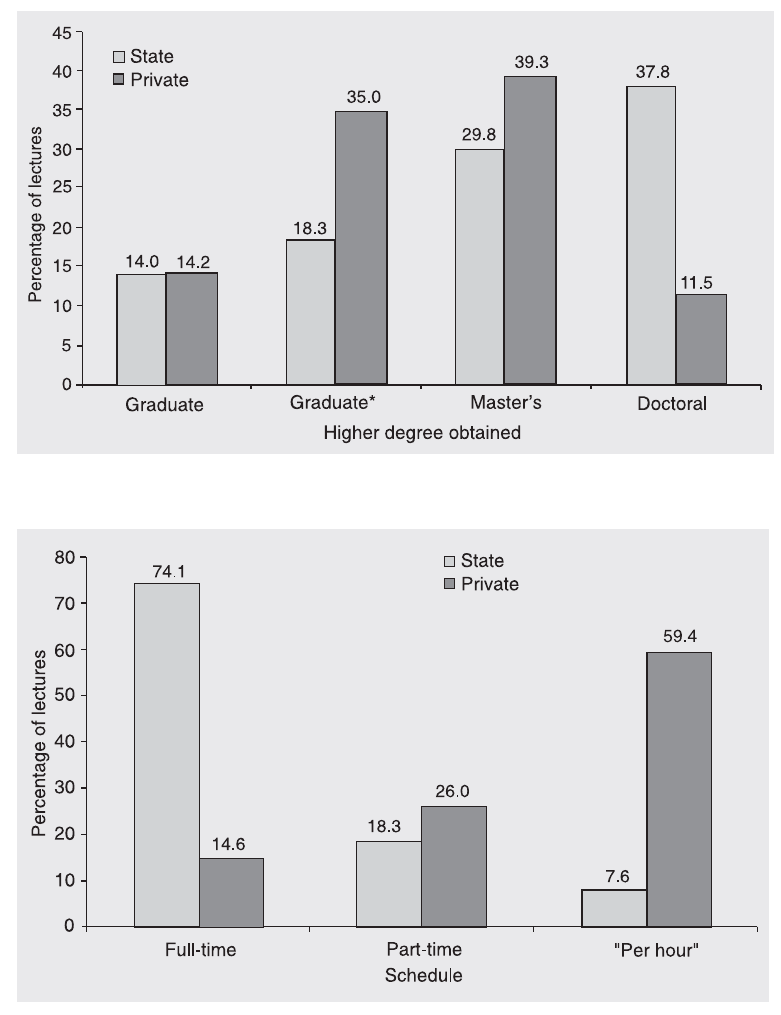
Figure 12. Percentage of lecturers employed by state and private universities as a function of higher degree obtained, calculated based on data available in June 2003 (original data source: INEP, http://www.inep. gov.br/). *Graduate with 1 year additional study.